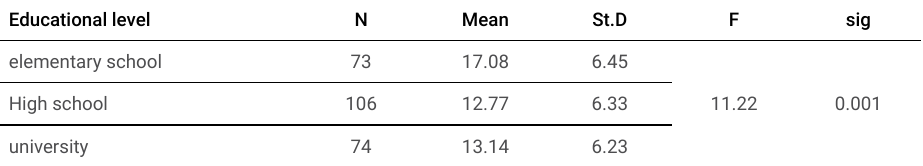
Table 3. ANOVA test to compare dental anxiety in three groups of elementary, high school and university level Educational level N Mean